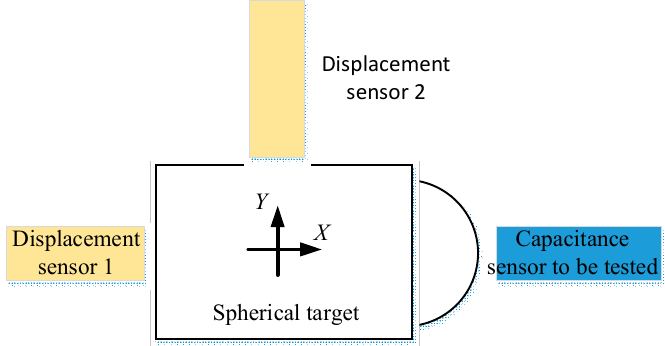
Figure 6. Nonlinear test device of capacitive displacement sensor.